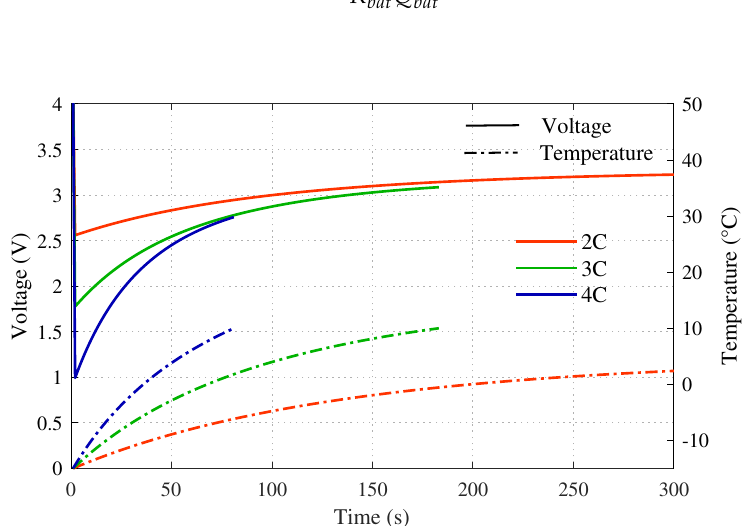
Figure 7. Terminal voltage and cell temperature responses at different discharge rates for a single Li-ion 18650 cell as heated from − 15 ◦ C to 10 ◦ C at different discharging